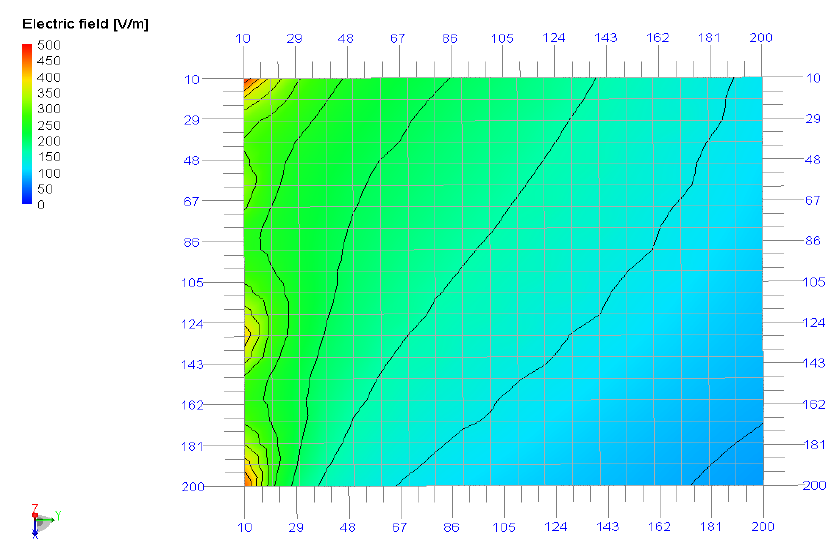
Figure 7. Antenna pattern .